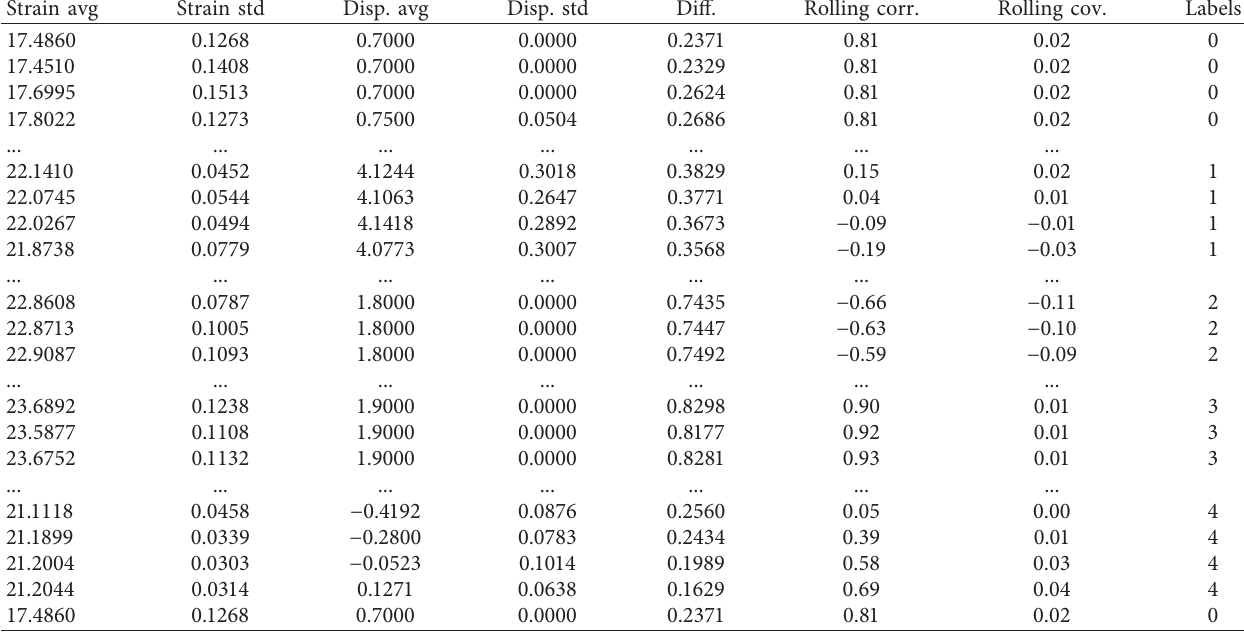
Table 5: The training and testing dataset of